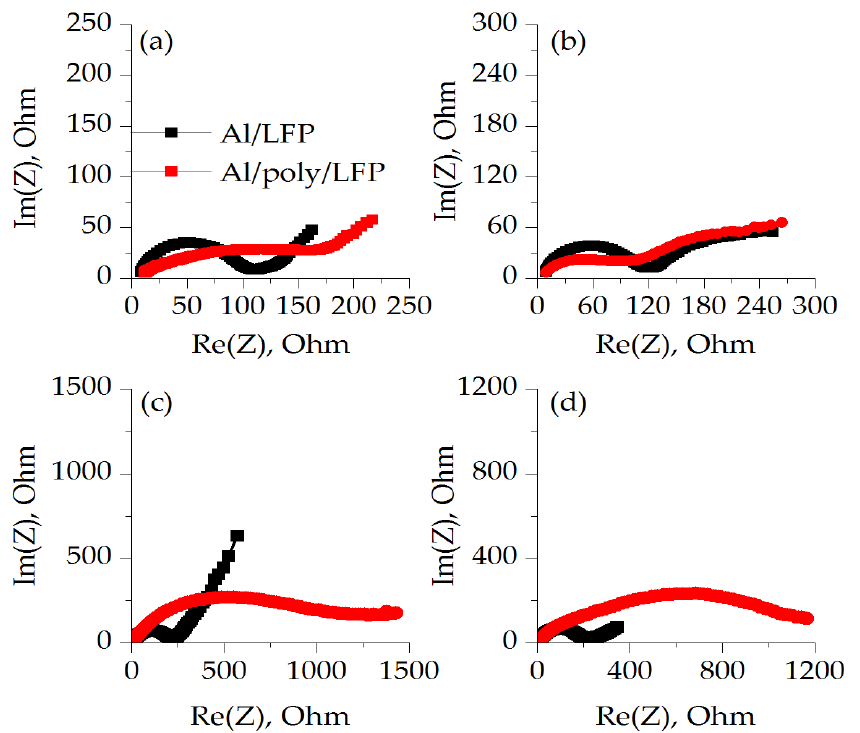
Figure 6. Impedance spectroscopy of non-protected (Al/LFP) and protected (Al/poly/LFP) elec- trodes after OCV equilibration charged to 4 V ( a ), discharged to 2.5 V ( b ), after short circuit ( c ) and charged to 4 V after short circuit ( d ). Table 1. Charge transfer resistances of non-protected (Al/LFP) and protected (Al/poly/LFP) cells at different conditions.